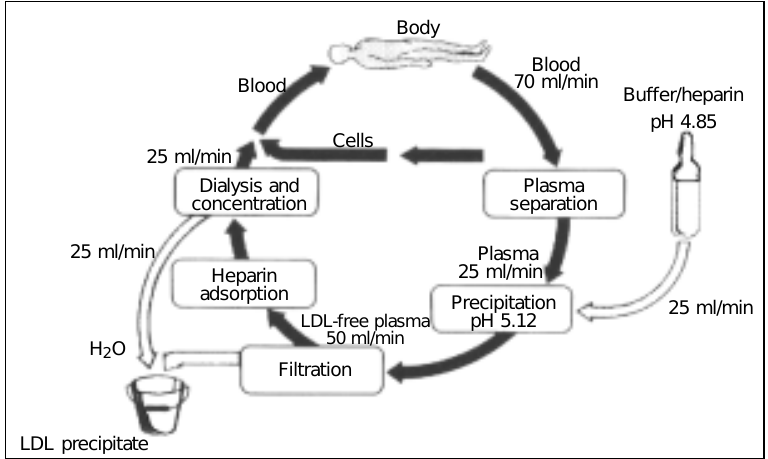
procedures.LDL Figure 1. Flow sheet of the HELP